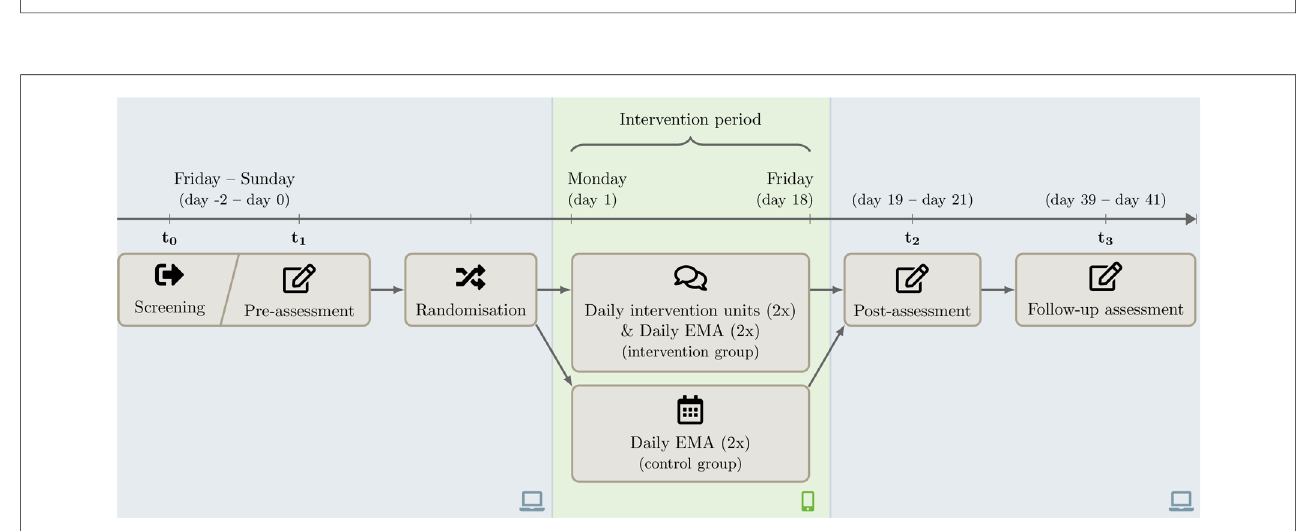
FIGURE 2 Participant timeline for the intervention and the control group. EMA, Ecological momentary assessment.